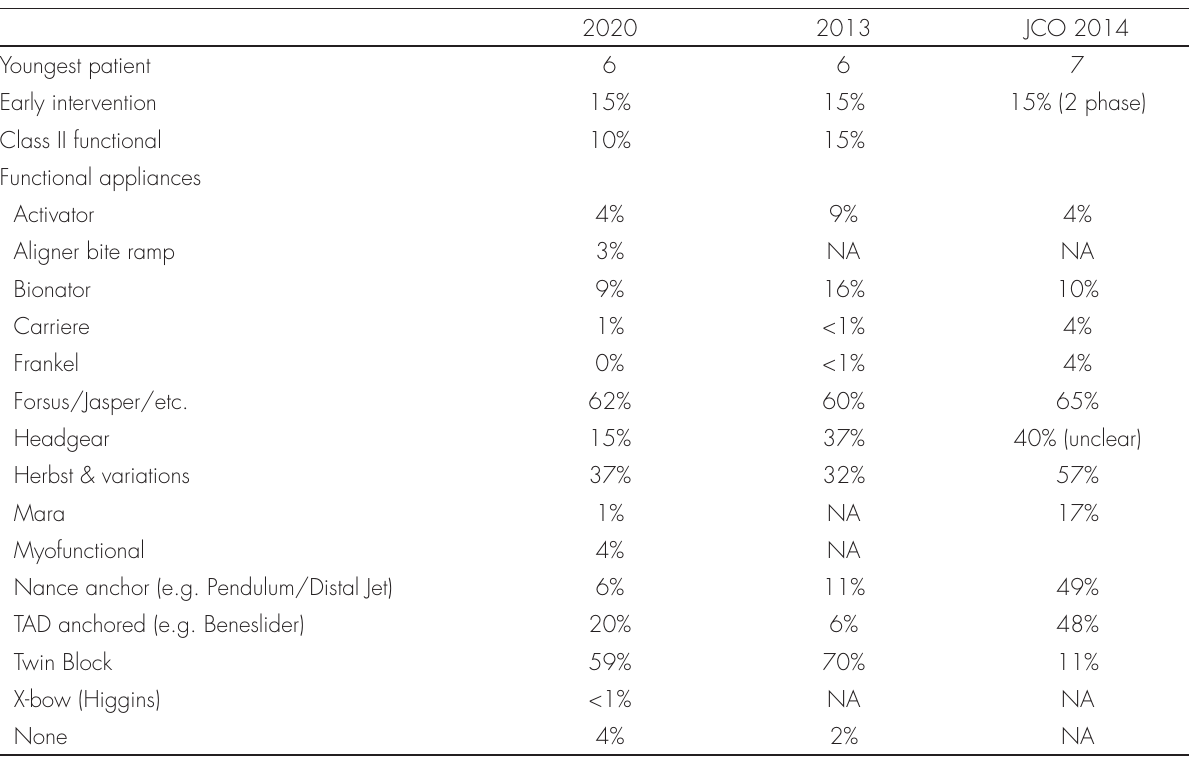
Table III. Early